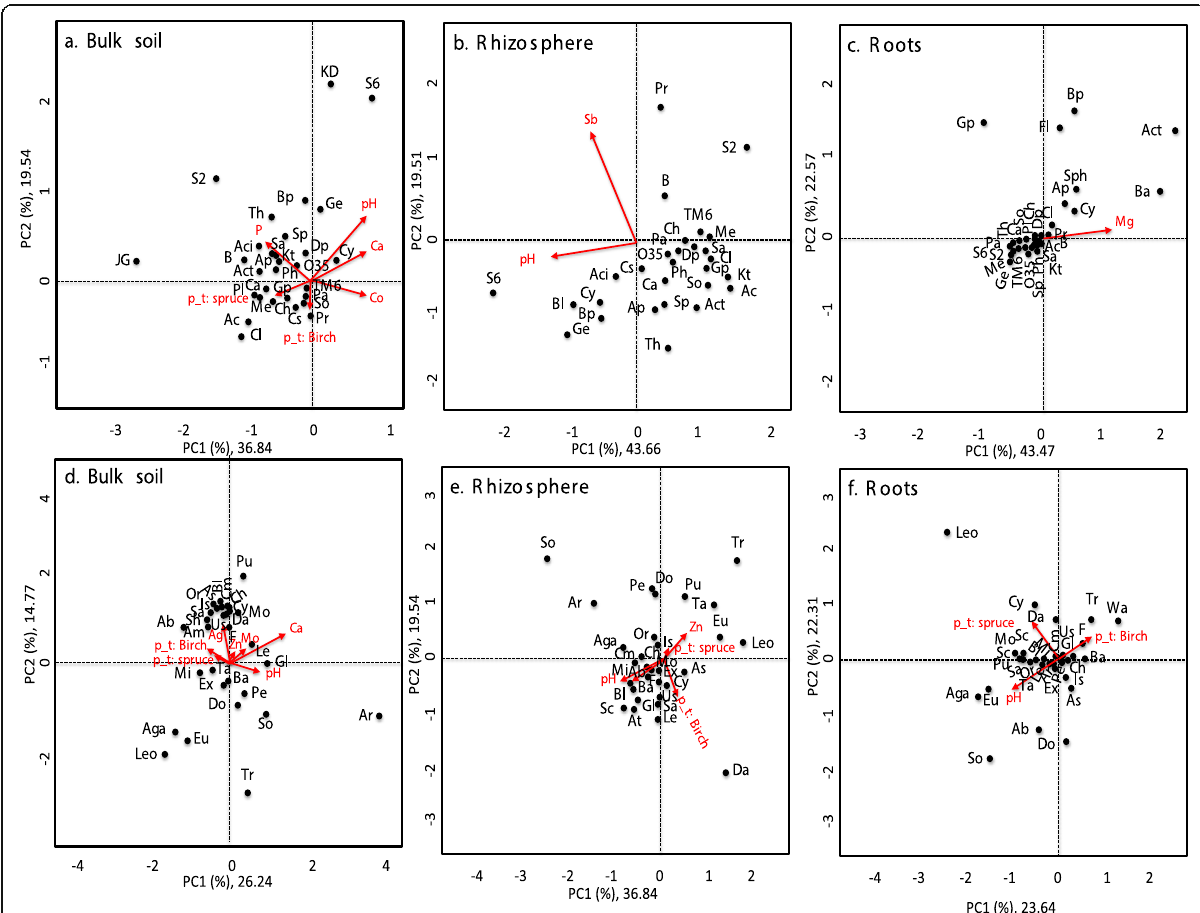
Fig. 2 a – c Redundancy analysis (RDA) of the effect of soil environmental variables on the composition of bacterial classes in bulk soil ( a ), the rhizosphere ( b ), and roots ( c ). d – f RDA of the effect of soil environmental variables on the composition of fungal classes in bulk soil ( d ), the rhizosphere ( e ), and roots ( f ). Black points represent the 30 most abundant bacterial and fungal taxa. Red arrows indicate soil significant variables. a – c Legend: Ac, Acidobacteria; Aci, Acidimicrobiia; Act, Actinobacteria; Ap, Alphaproteobacteria; B, k_Bacteria; Ba, Bacilli; Bl, Blastocatellia; Bp, Betaproteobacteria; Ca, Candidatus Azambacteria; Ch, Chlamydiae; Cl, Clostridia; Cy, Cytophagia; Dp, Deltaproteobacteria; Fl, Flavobacteria;